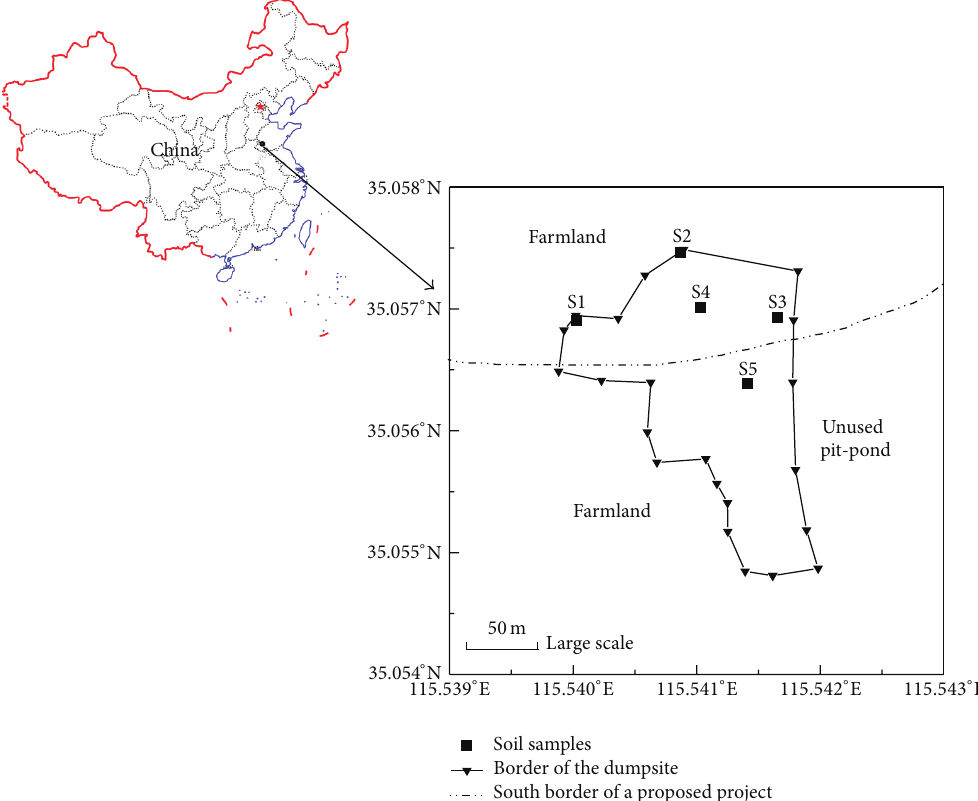
Figure 1: Range of the open dumpsite and locations of soil sampling in the study